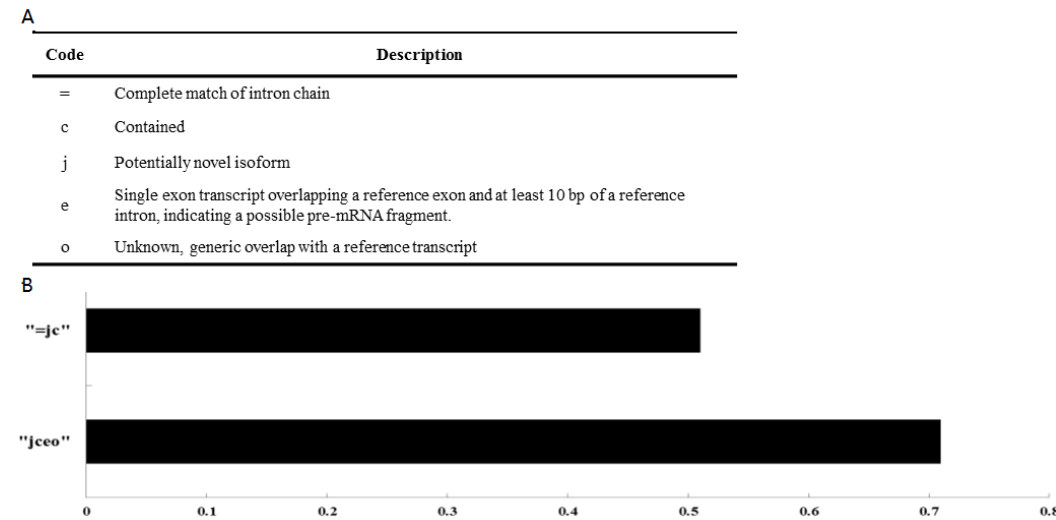
Figure 2. ( A ) Different classes of assembled transcripts according to their relative positions with known coding genes; ( B ) Ratio of the reconstructed transcripts to known coding genes.